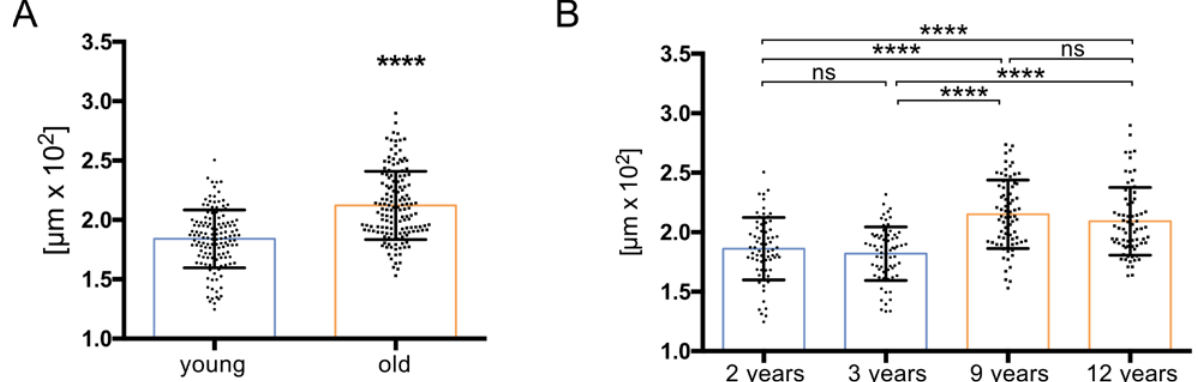
Figure A1. Tubular diameter of young (2 and 3 years, total n = 138 tubules) and old (9 and 12 years, total n = 153 tubules) C.